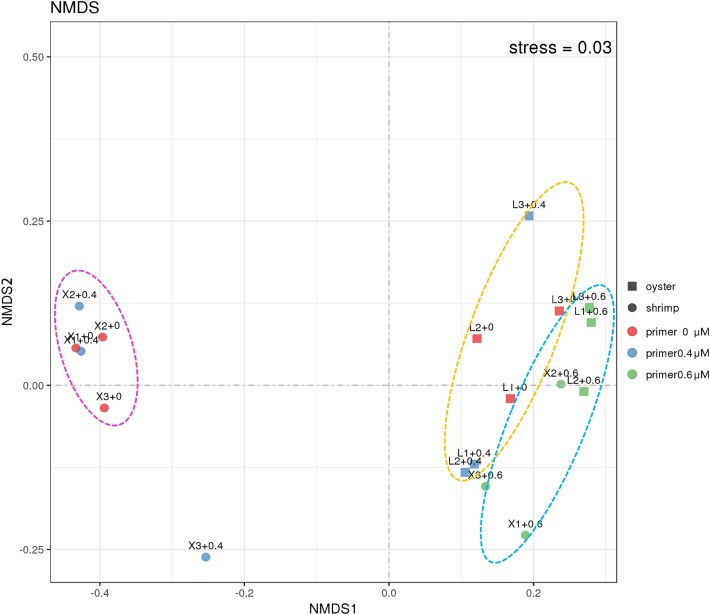
NMDS analysis of the 18S community in shrimp and oyster samples. Stress is the measure of the degree of dissimilarity between the object structure and the original distance matrix in the sort space based on Kruskal stress formula I. When stress <0.05, it means that the sample is highly representative based on Bray-Curtis distance between the 18S ASVs composition of different samples (Netburn and Koslow, 2018). “+0,” “+0.4,” and “+0.6” imply shrimp (circles) and oyster samples (square) were amplified with the blocking primer, X-BP2-DPO at the concentrations of 0 μM (red), 0.4 μM (blue), and 0.6 μM (Green) in PCRs.